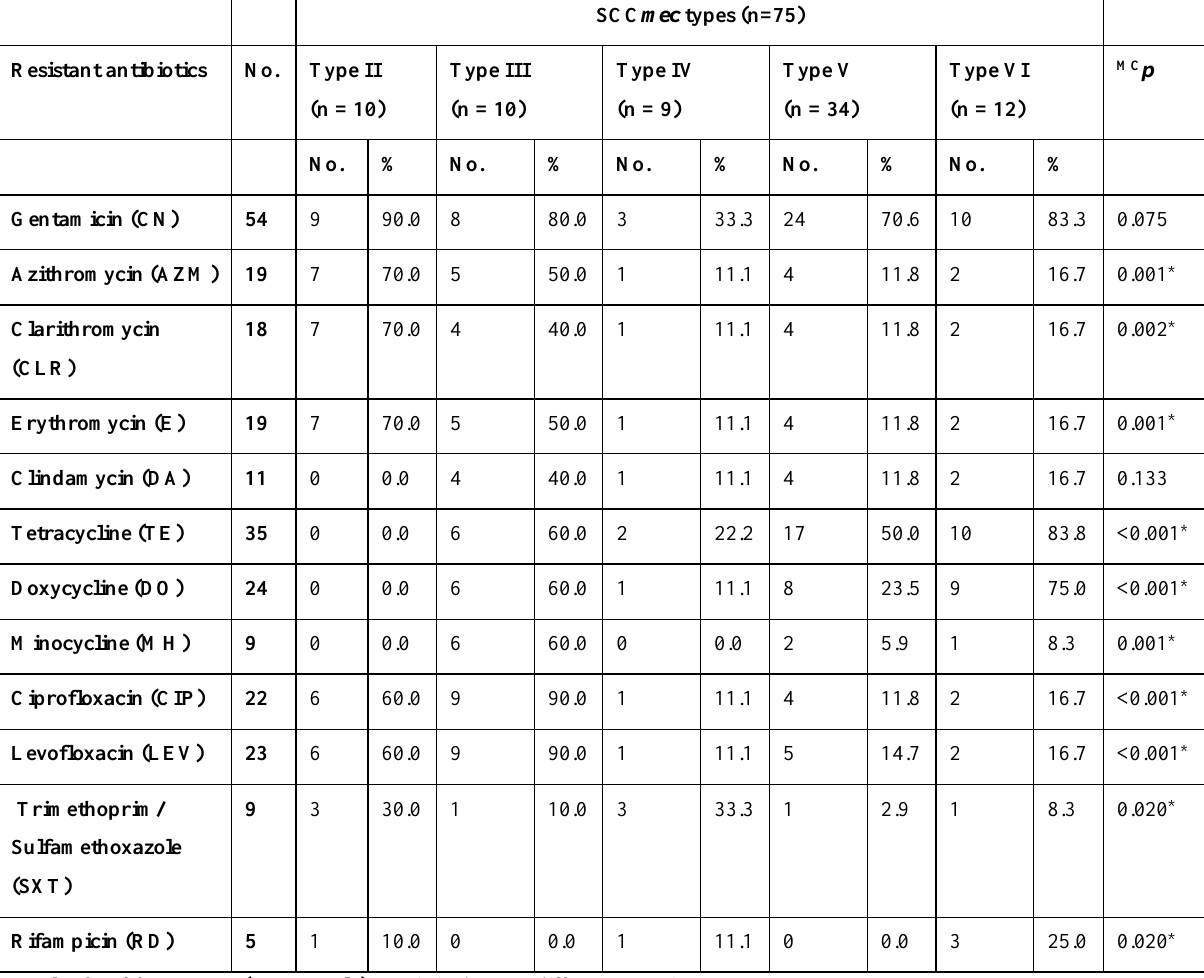
Table 5. Correlation between SCC mec types and antibiotic